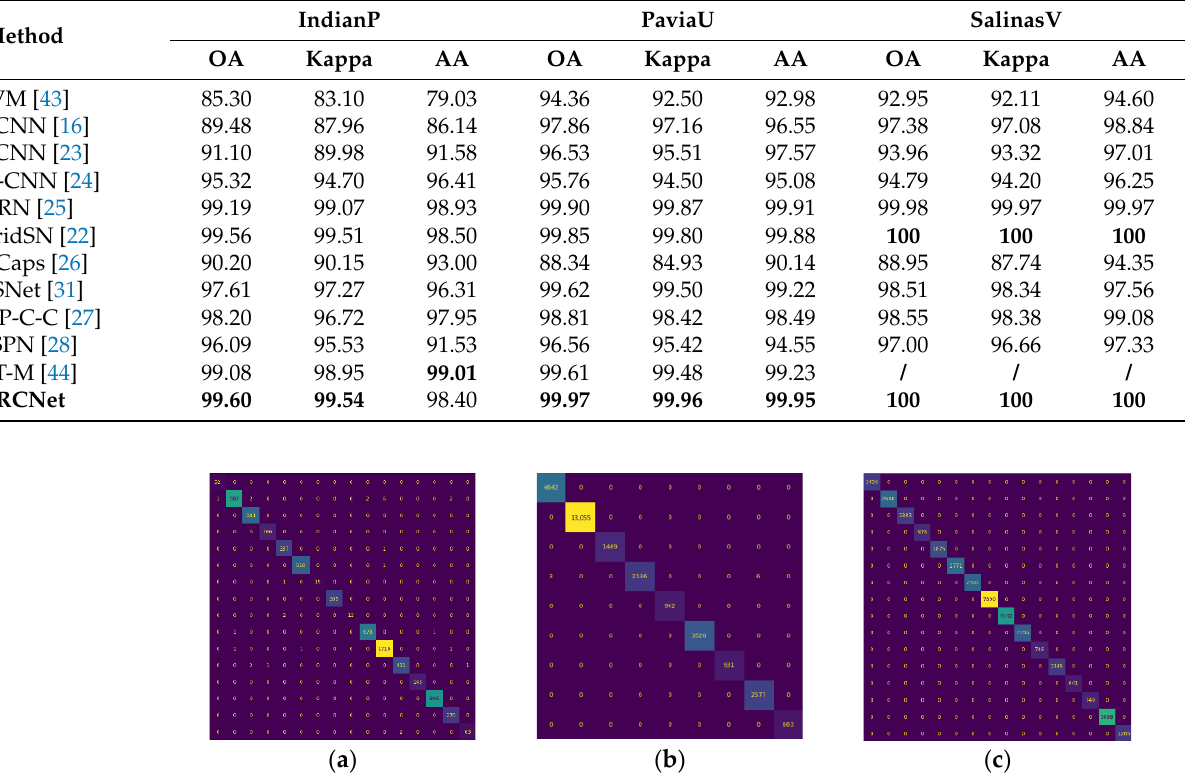
Table 1. The classification accuracy comparison for the IndianP, PaviaU, and SalinasV datasets (%). IndianP Method